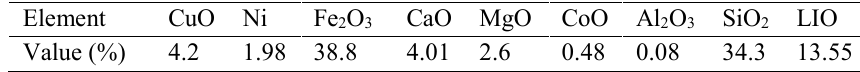
Table 1. Chemical composition of the converter slag sample